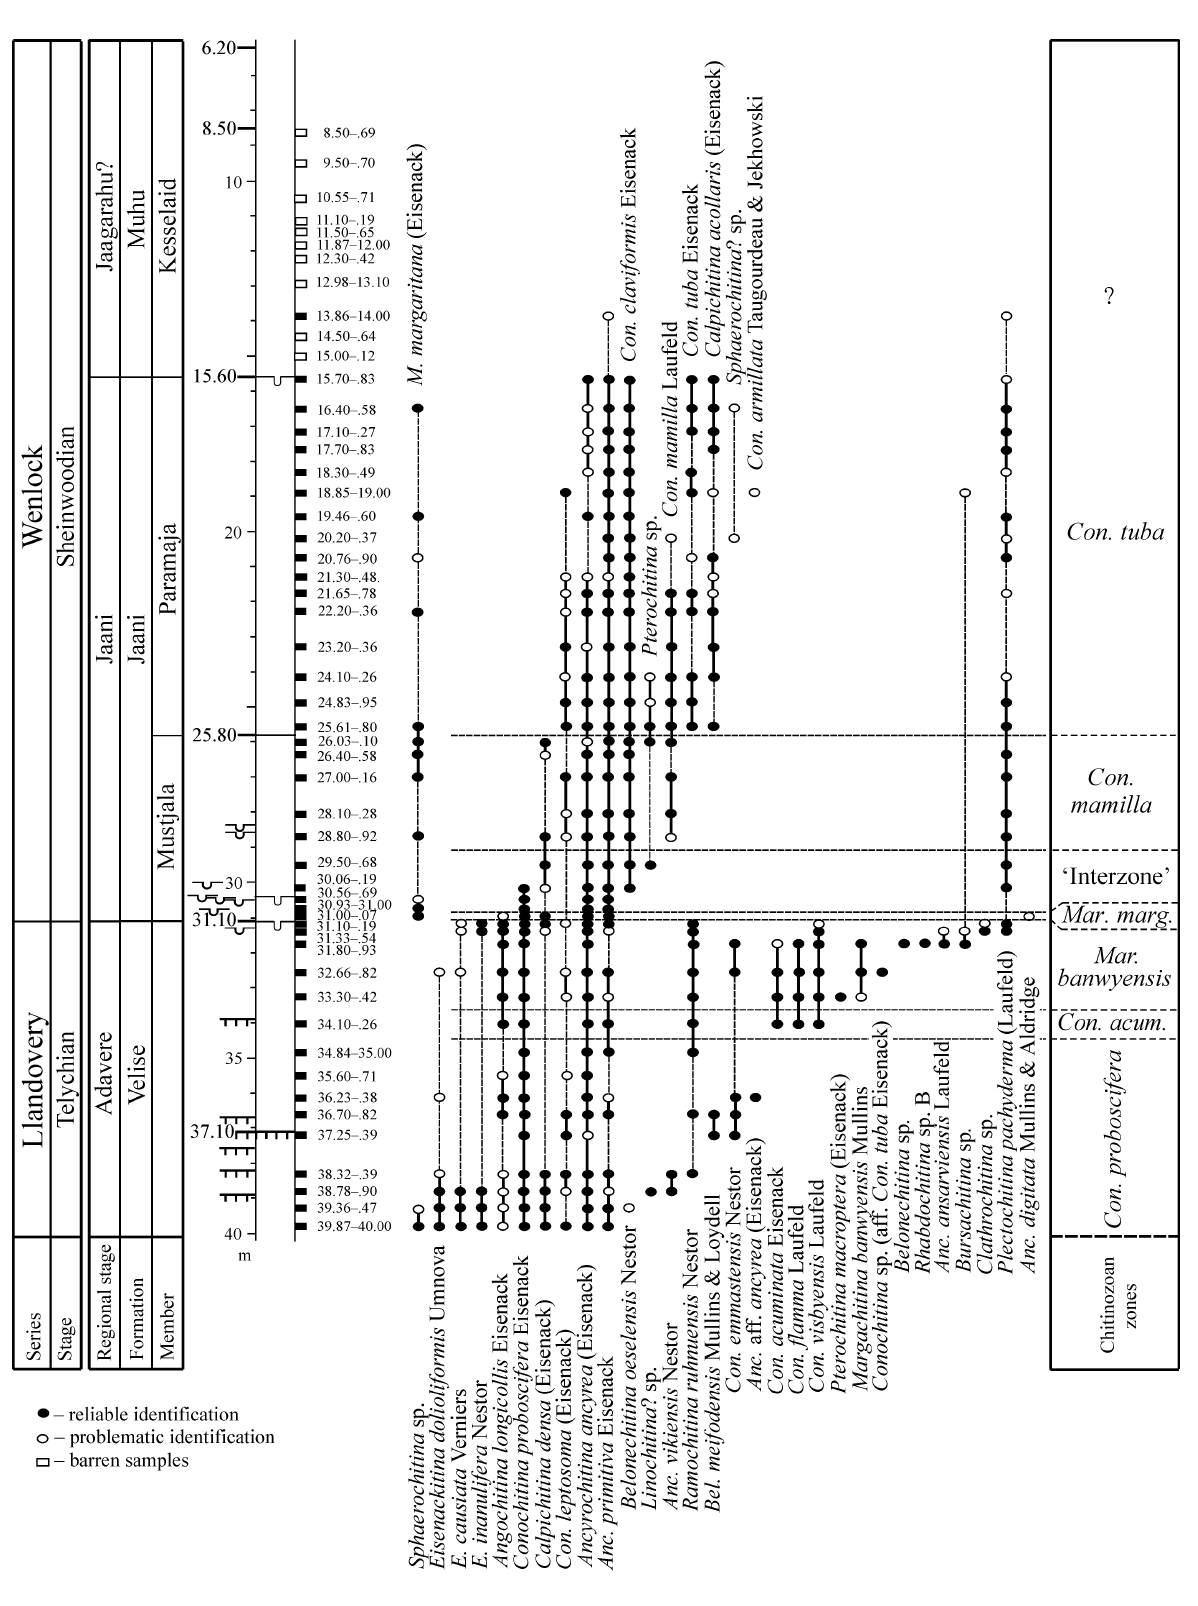
Fig. 4. Distribution of chitinozoans in the Suigu (S-3) core section. Con. acum. , Conochitina acuminata ; Mar. marg. , Margachitina margaritana . For legend see Fig.